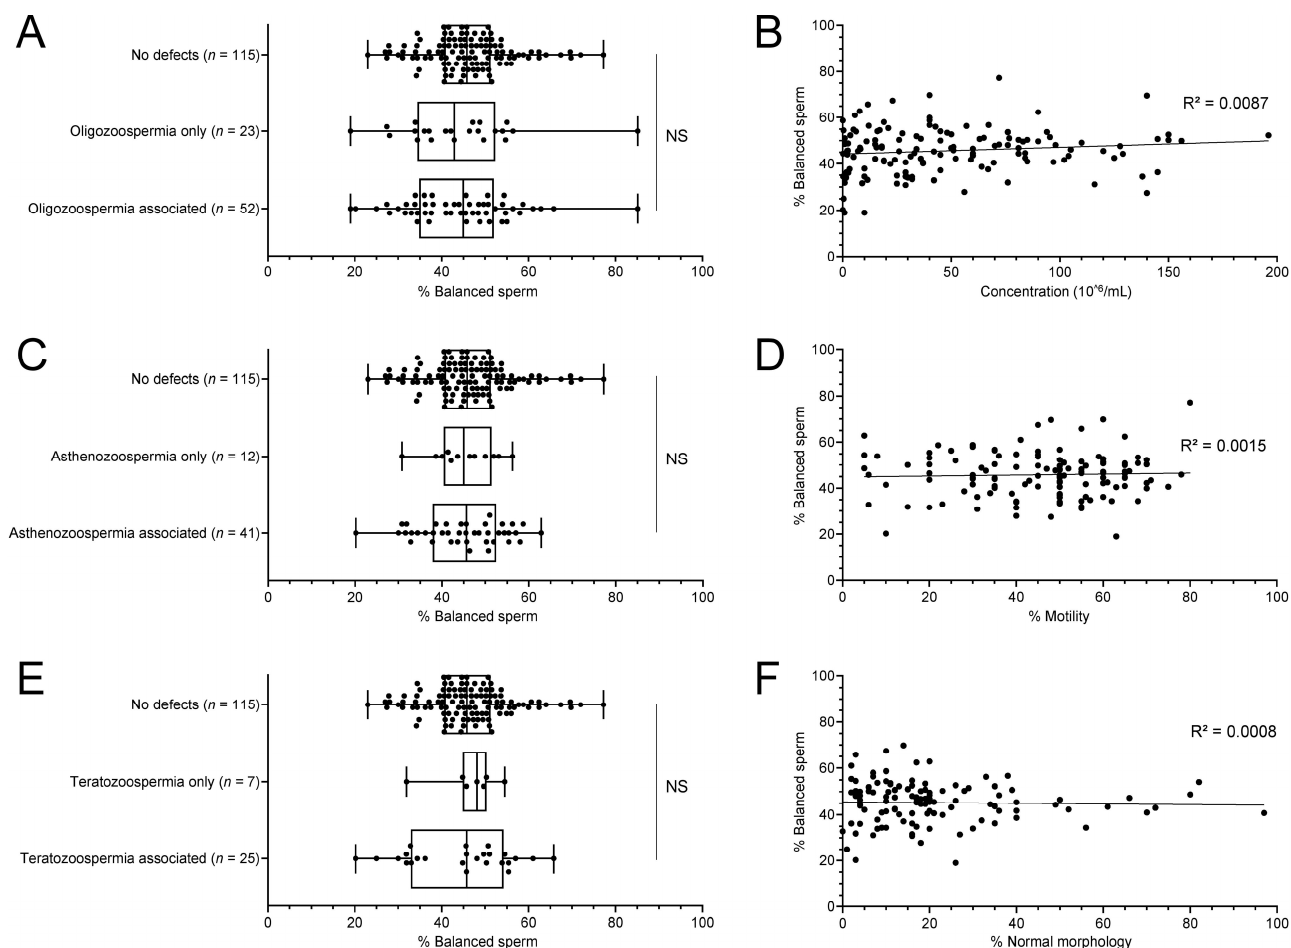
Figure 3. No correlation observed between balanced sperm rates and sperm parameters. Concentration ( A , B ), motility ( C , D ), and morphology ( E , F ) parameters are not correlated with the rate of balanced sperm in RT carriers, whether each parameter is considered alone or associated with others. NS—not significant. Corresponding statistical data can be found in Supplementary Materials Tables S2–S4.